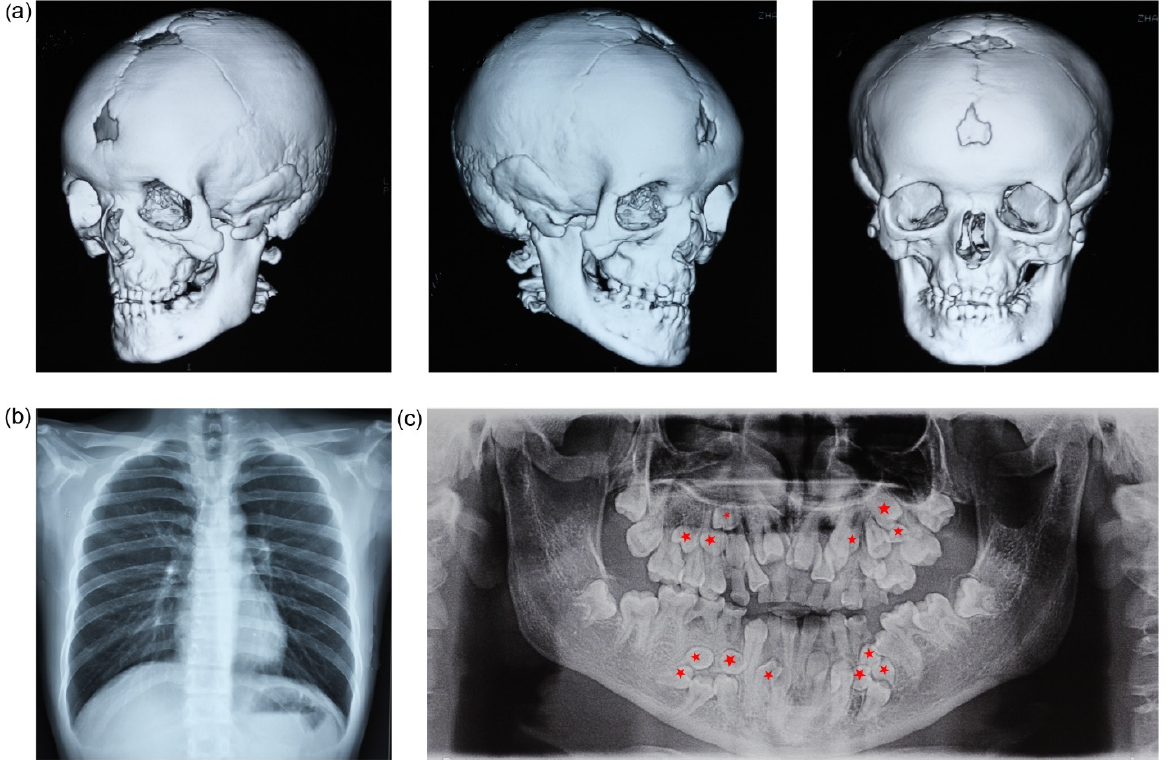
Figure 1. Clinical and radiographic findings of the proband. ( a ) Different views of CT images. The skull shows non-closing fontanel, frontal bossing, and malocculusion. ( b ) Chest radiograph demonstrates cone-shaped thorax and hypoplasia of clavicles. ( c ) Panoramicradiograph shows dental anomalies, including 13 supernumerary teeth (red stars), 14 retained deciduous teeth (51–53, 61–65, 72–74, 82, 84, 85), and 16 failed eruption of permanent teeth (11–13, 21–25, 32–35, 42, 44, 45, 47) (not including the third molars, which have to be followed up).